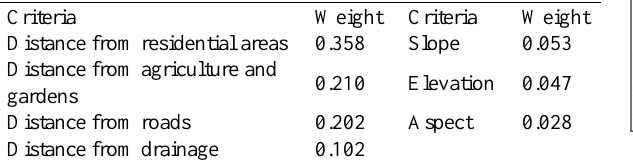
Table 3. Priorities calculated by pairwise comparison of the criteria which influence deforestation